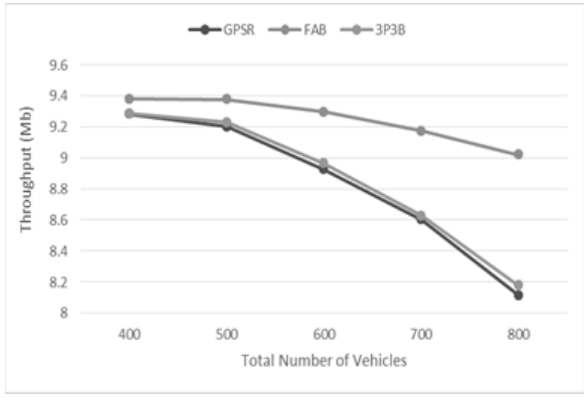
Fig. 7. The throughputs of FAB, GPSR, and 3P3B with various vehicle numbers.